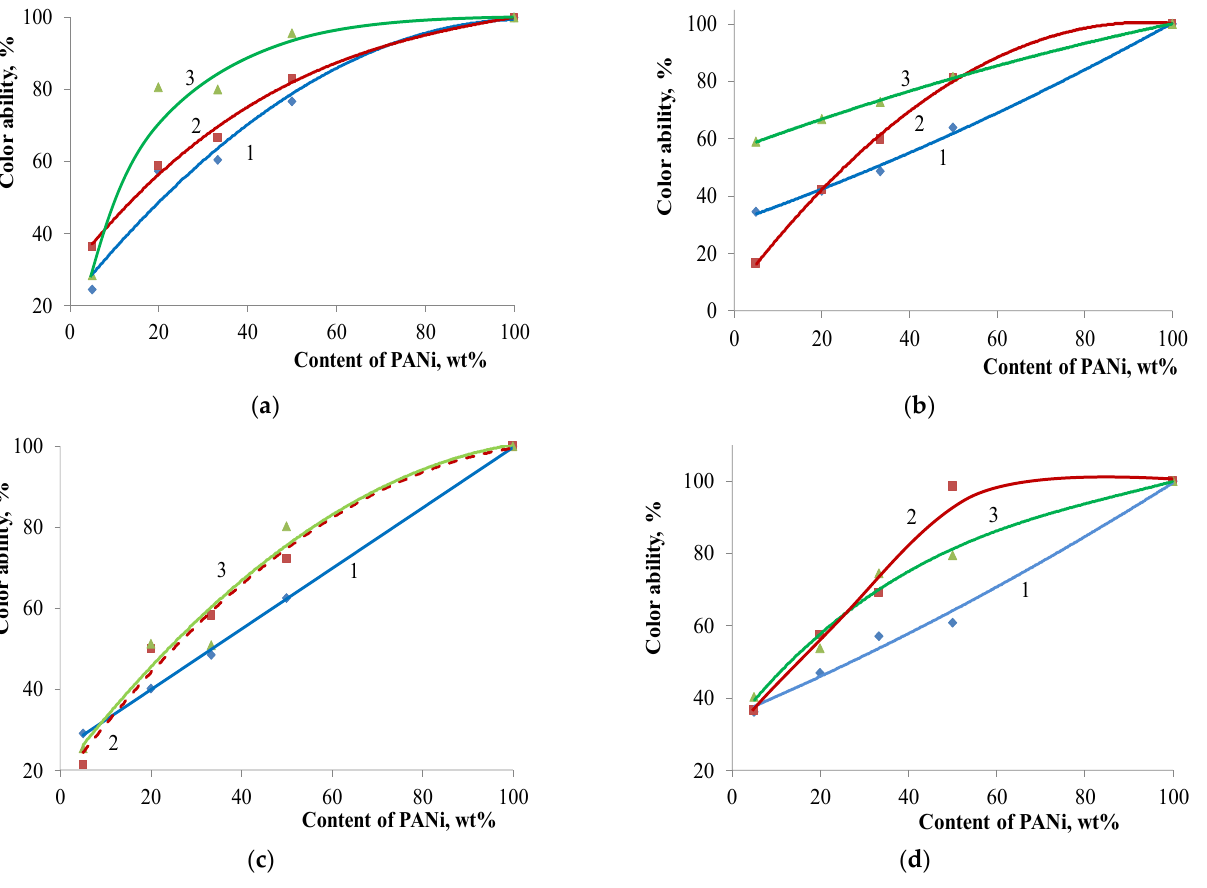
Figure 11. Core/shell pigment blackness vs. PANi content with various cores. The core of the pig- ment: (1) kaolin; (2) talc; (3) bentonite; (4) muscovite.